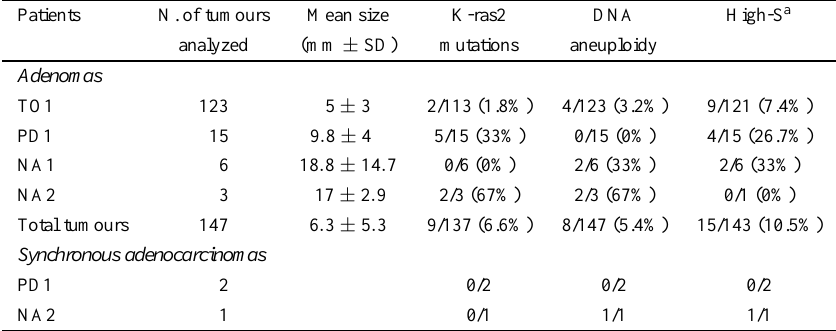
K-ras2 mutations, DNA aneuploidy, and high S-phase among 147 colorectal adenomas and 3 adenocar- cinomas in 4 FAP patients Patients N. of tumours